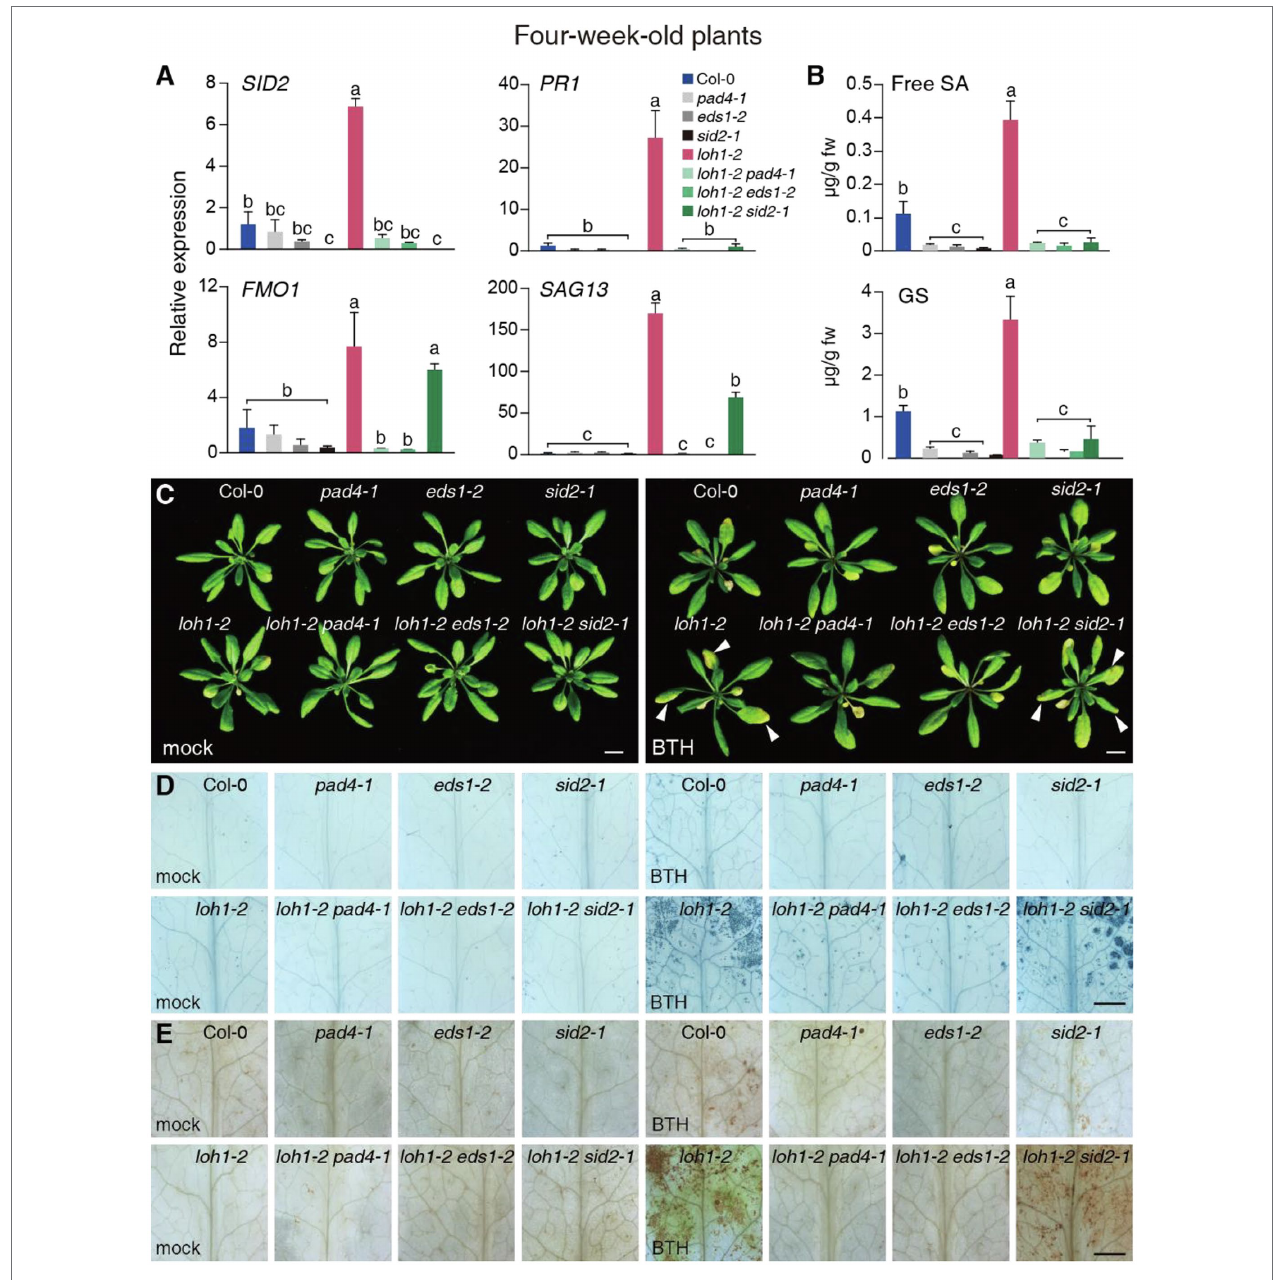
FIGURE 1 | Effect of the pad4-1, eds1-2, and sid2-1 mutations on benzothiadiazole (BTH) treatment in loh1-2 . (A) Relative transcript levels of SALICYLIC ACID INDUCTION DEFICIENT 2 ( SID2 ), PATHOGENESIS RELATED-1 ( PR1 ), FLAVIN-DEPENDENT MONOOXYGENASE 1 ( FMO1 ), and SENESCENCE-ASSOCIATED GENE 13 ( SAG13 ) in 4-week-old plants. ACT2 served as the internal control. Values were normalized to Col-0 levels (set to 1). (B) Free salicylic acid (SA) and glucosylated SA (GS) levels were measured in the indicated plants. (C) Representative images of plants (inflorescence stems were removed before we photographed the plants) treated with BTH. Three-week-old plants were sprayed with 300 μ M BTH and observed 1 week later. White arrowheads indicate cell death lesions. Bar = 1 cm. (D) Trypan blue staining of leaves from (C) . Bar = 1 mm. (E) DAB staining of leaves from (C) . Bar = 1 mm. Values are means ± SE from triplicate biological repeats; different letters indicate significant differences, as determined by Fisher’s PLSD ( p < 0.05) in (A,B) . At least, 40 plants per line were tested each time in (C) and at least 12 leaves per line were stained each time in (D,E) . All experiments were conducted at least three times using independent